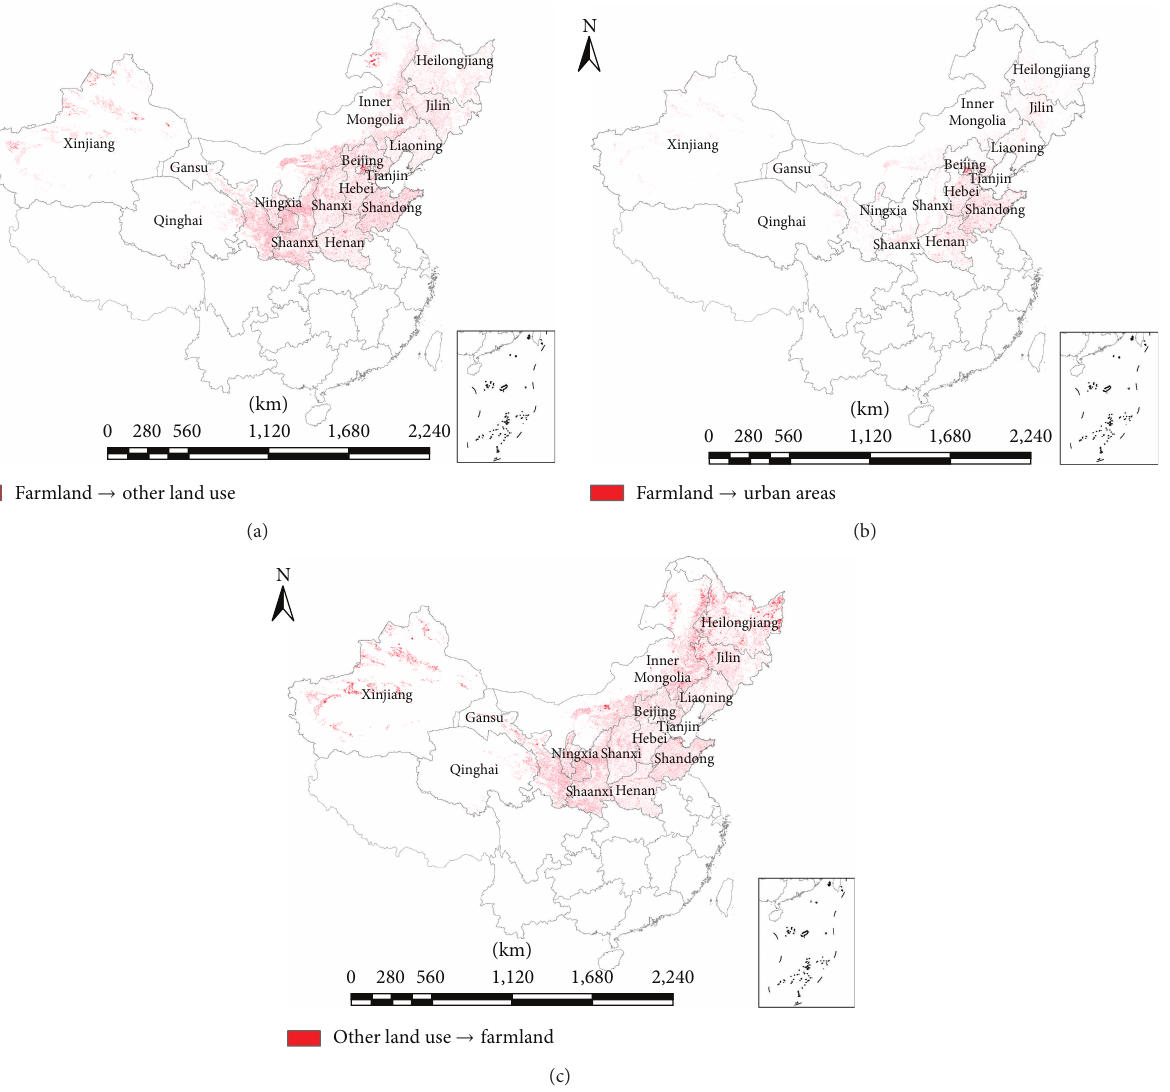
Figure 5: Farmland dynamics from the late 1980s to 2008: (a) conversion from farmland to urban areas, (b) conversion from farmland to other land-use types, and (c) conversion from other land-use types to farmland.